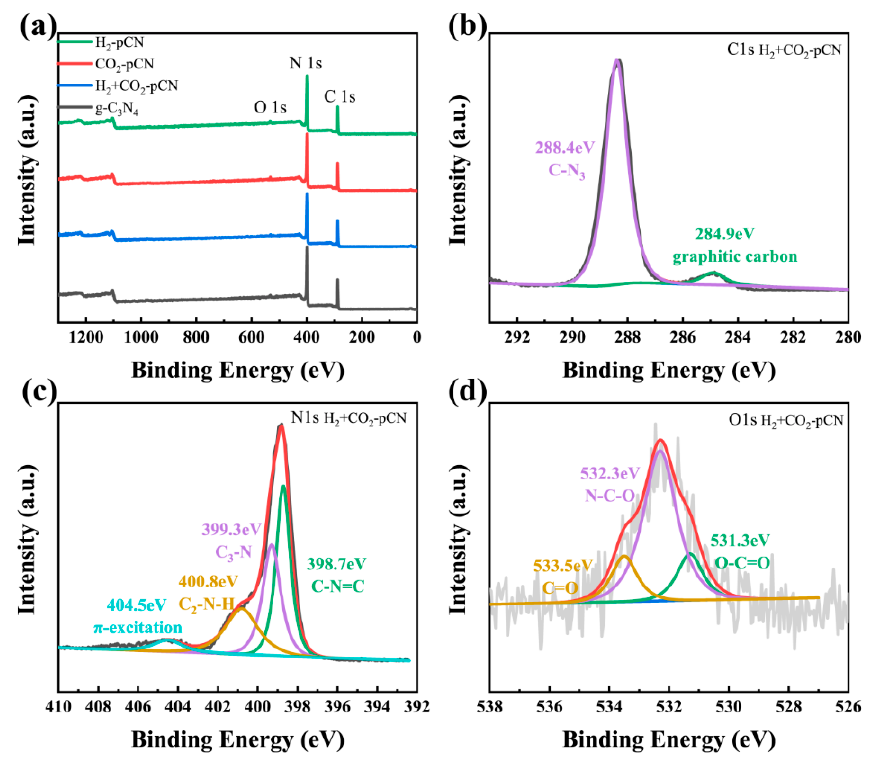
Figure 5. ( a ) XPS survey spectra of raw g-C 3 N 4 , H 2 -pCN, CO 2 -pCN, and H 2 +CO 2 -pCN. ( b ) C 1s XPS, ( c ) N 1s XPS, and ( d ) O 1s XPS spectra of the optimal H 2 +CO 2 -pCN.